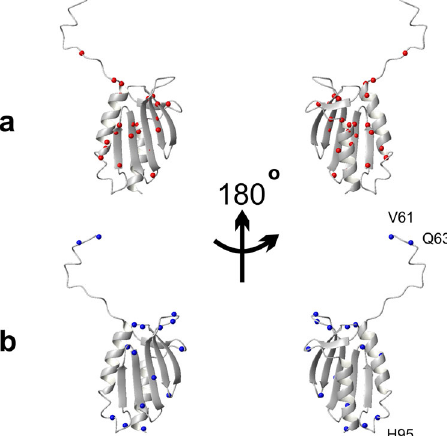
Fig. 2 Distribution of residues on the structure of Yfh1. We used the reference pdb fi le 2fql. a Distribution of the nitrogen atoms of residues for which the difference in the unfolding temperatures with respect to values of the RAD_0.1 curve ( Δ T m and Δ T c ) is on average below 1.5K. b Distribution of the N atoms of residues for which the difference in the unfolding temperatures with respect to values of the average curve ( Δ T m and Δ T c ) is on average above 3K. Indicated explicitly are the three residues whose stability curve is most shifted to lower temperatures with respect to the average RAD_0.1. The structure pairs are rotated by 180 degrees around the y